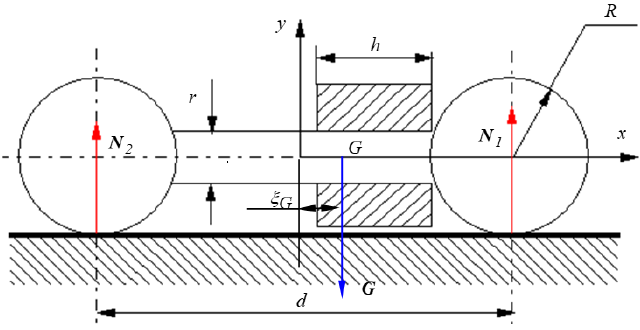
Figure 8. Eccentric rotor.